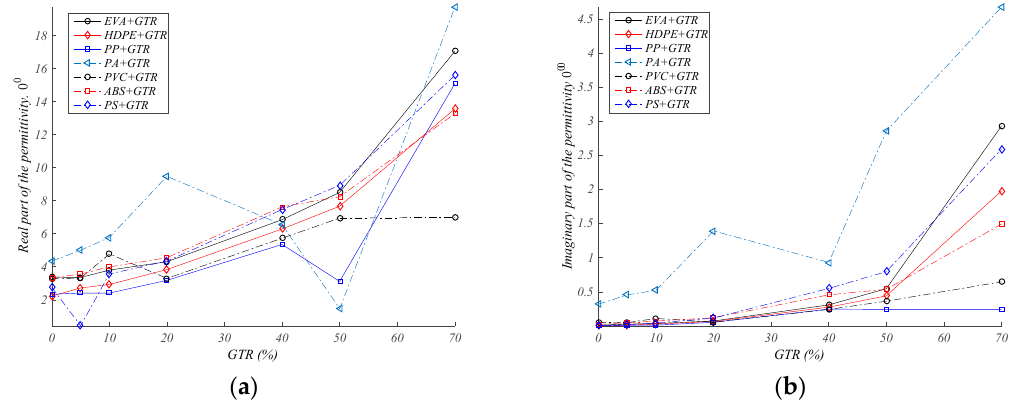
Figure 9. ( a ) Real part of the permittivity ( ε (cid:48) ), ( b ) imaginary part of the permittivity ( ε ”), for di ff erent polymers / GTR concentrations and particle size < 200 µ m, frequency fixed at 50 Hz and 30 ◦